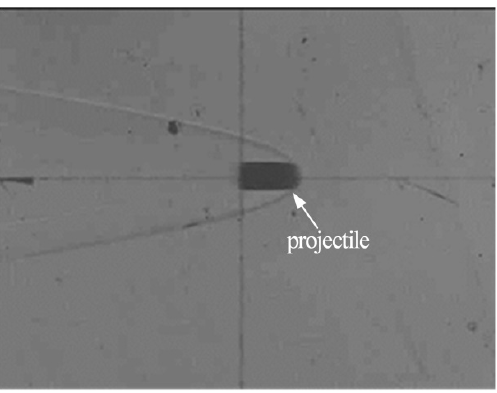
Figure 4. The typical record of the ballistic trajectory of a projectile before impact.